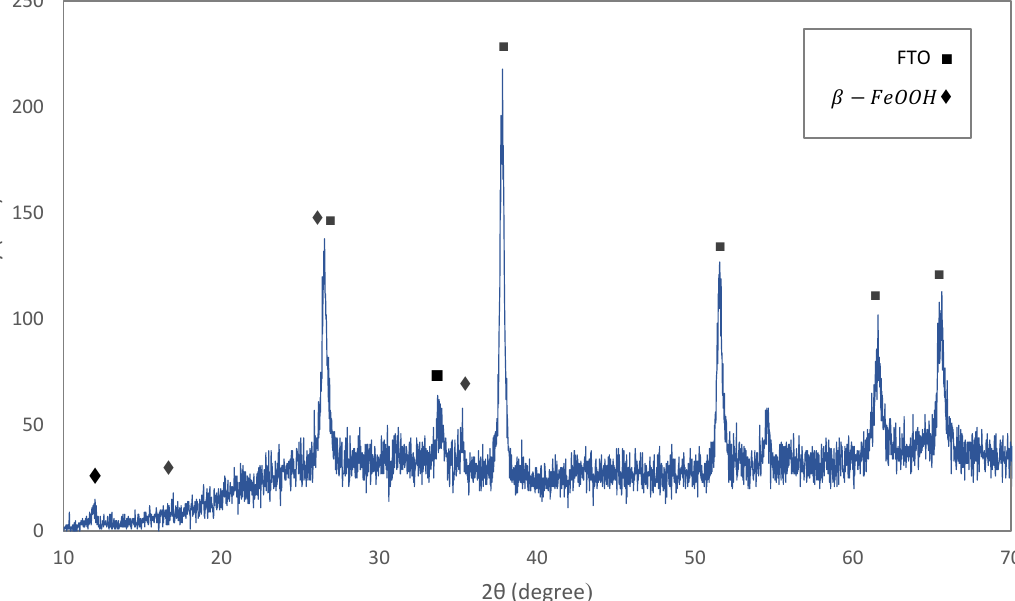
Figure 3. The XRD pattern of the sample β -FeOOH as grown on fluorine-doped tin oxide (FTO) substrate.